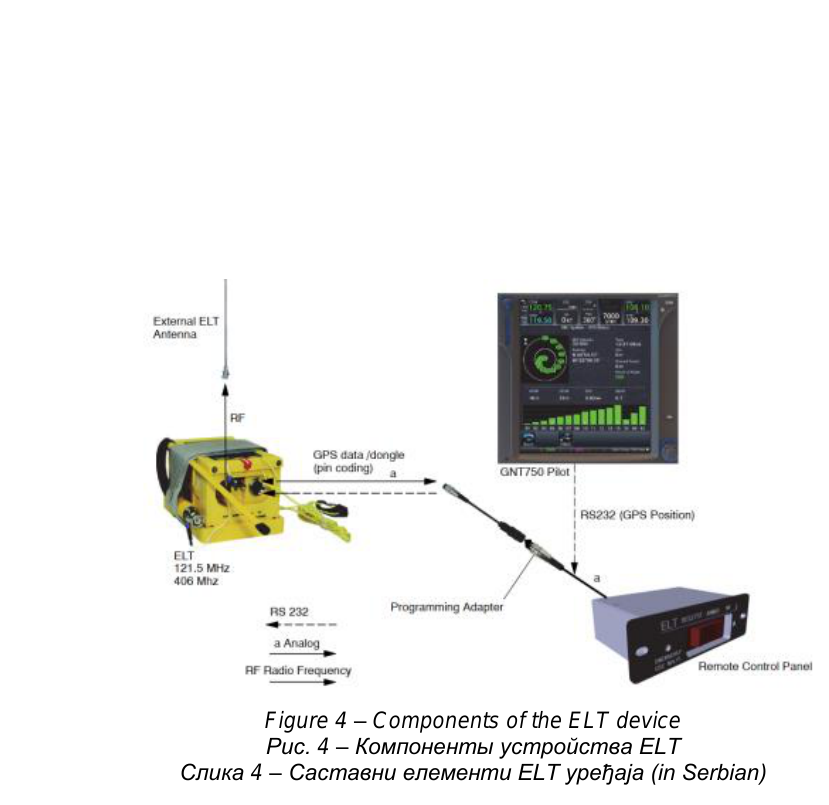
Figure 4 – Components of the ELT device Рис. 4 – Компоненты устройства ELT